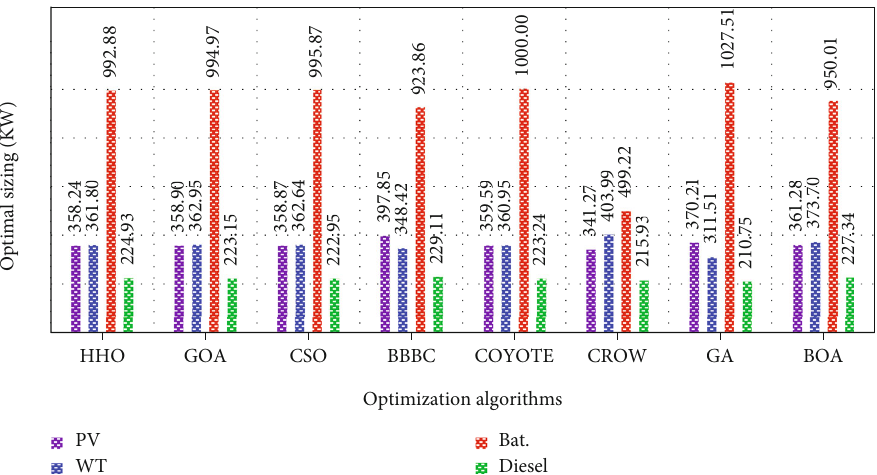
Figure 5: The optimal PV, WT, diesel, and battery sizing of the metaheuristic algorithms.